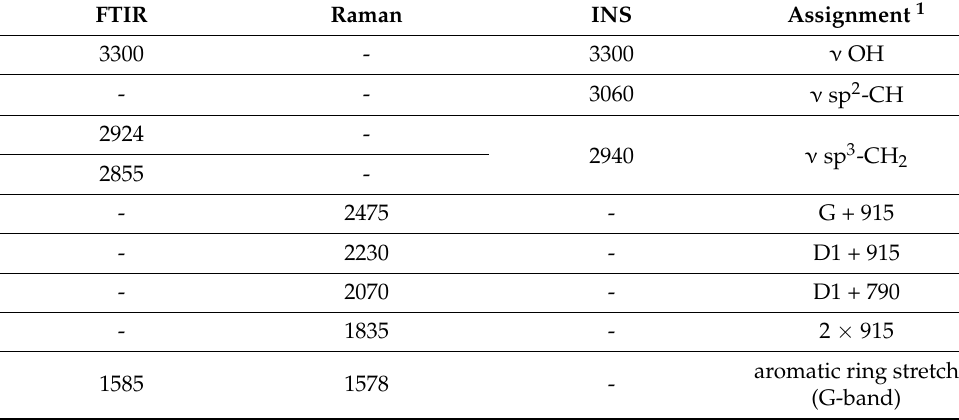
Table 3. Transition energies (cm − 1 ) of BCR and vibrational